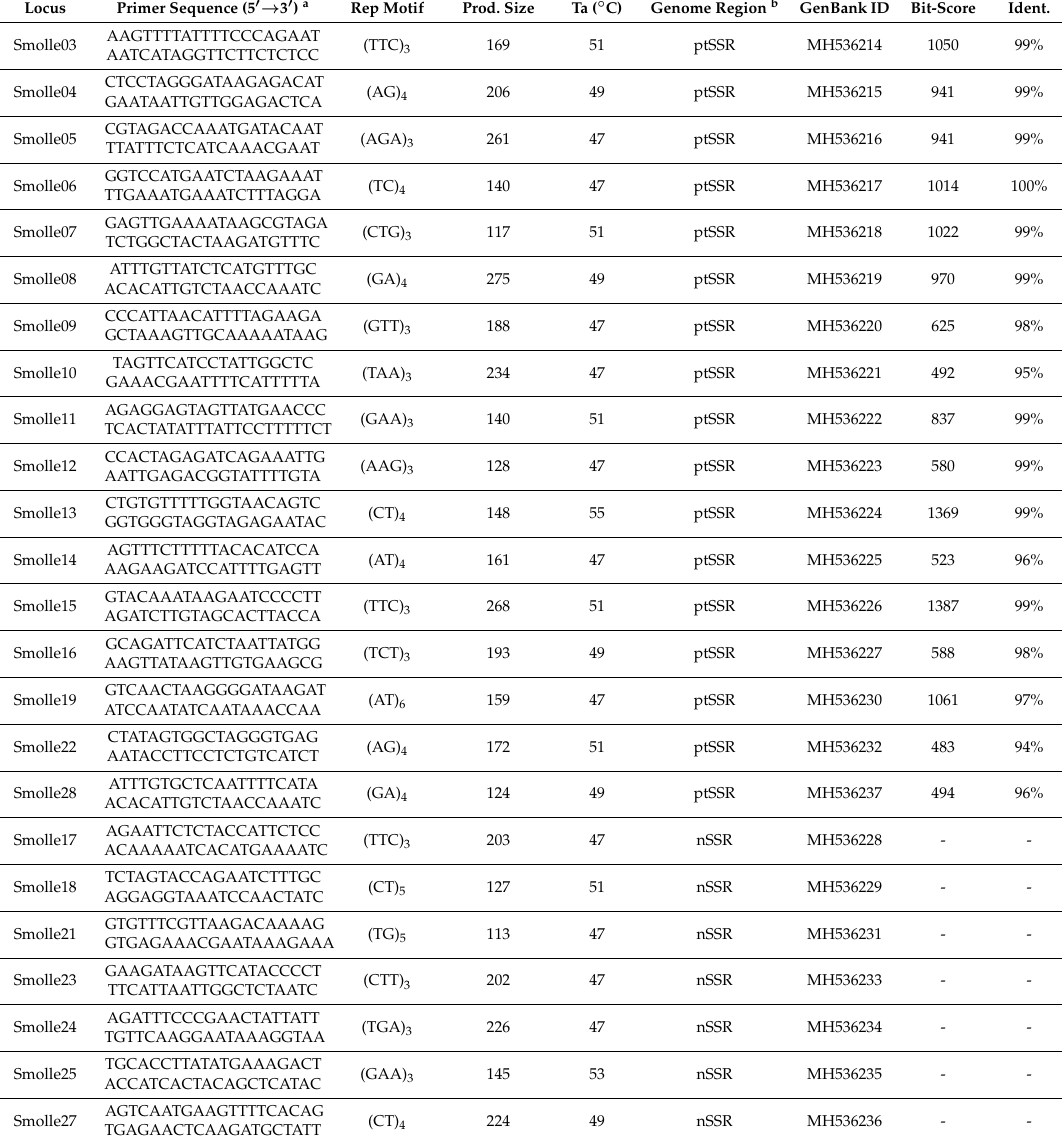
Table 1. List of 24 SSR markers characterized for Schinus molle , including primer sequences (forward and reverse), repeat motif, length of the sequenced fragment, annealing temperature (Ta), genome region, GenBank accession number (GenBank ID), the bit-score and the identity of the contig to the subject sequence in the BLAST